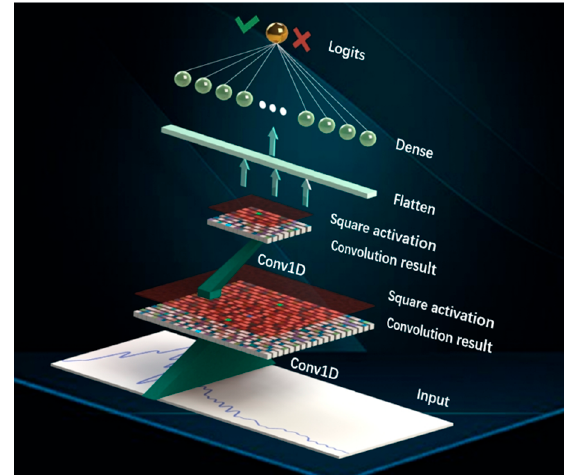
Figure 3. Convolutional neural network (CNN) inferences on raw frequency-domain spectrum using two convolutional layers and one fully-connected layer. “Input” layer was a vector of 61 numbers. In the first “Conv1D” operation, which was represented as a green cone, input signals were convolved by 32 kernels with shape 1 × 3. Then the 30 × 32 shaped output was obtained and represented as a black-and-white grid. Subsequently, the “Square activation” operation was added as a light red square.